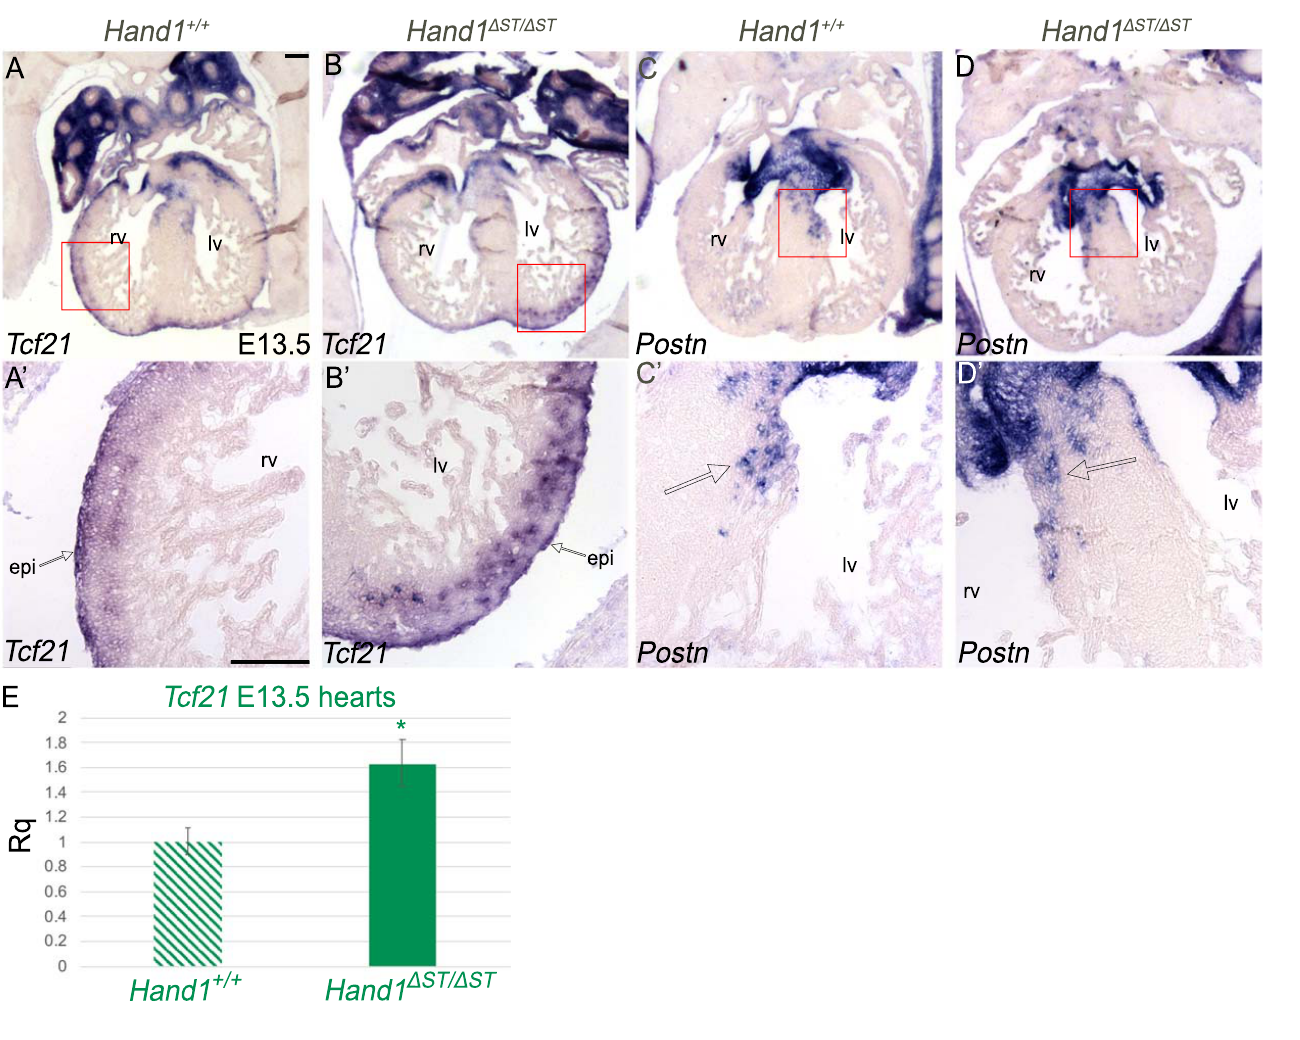
Figure 5. Development of The Epicardium is Unaffected in Hand1 ∆ ST/ ∆ ST Embryo. ( A , B ) and ( A ’, B ’) Section in-situ hybridization at E13.5 Hand1 +/+ and Hand1 ∆ ST/ ∆ ST embryos for Tcf21 showing four chamber view and at higher magnification. Arrow indicating epicardium. ( C , D ) and ( C ’, D ’) Section in-situ hybridization at E13.5 Hand1 +/+ and Hand1 ∆ ST/ ∆ ST embryos for Periostin ( Postn ) showing four chamber view and at higher magnification. Arrow indicating cardiac fibroblasts. rv, right ventricle; lv, left ventricle; epi, epicardium. Scale bar 100 µ m. ( E ) qRT-PCR at E13.5 for Tcf21 in Hand1 +/+ and Hand1 ∆ ST/ ∆ ST hearts. Significant increase in Tcf21 (* indicates p ≤ 0.01) is observed. Error bars represent the high and low range of replicate cycle reads within each primer